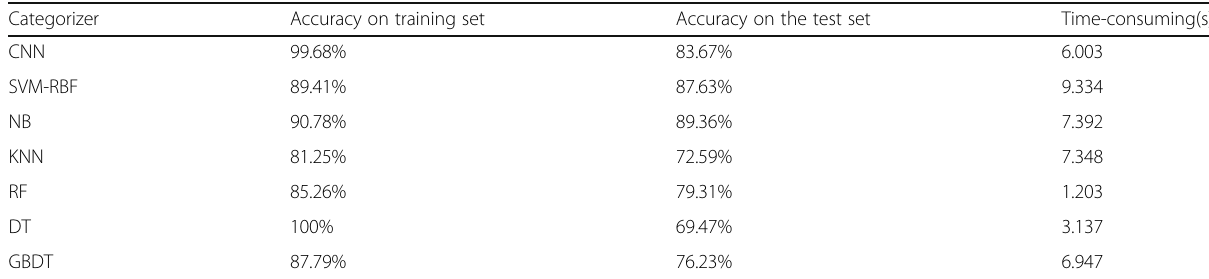
Table 1 Comparison before different classifiers Categorizer Accuracy on training set Accuracy on the test